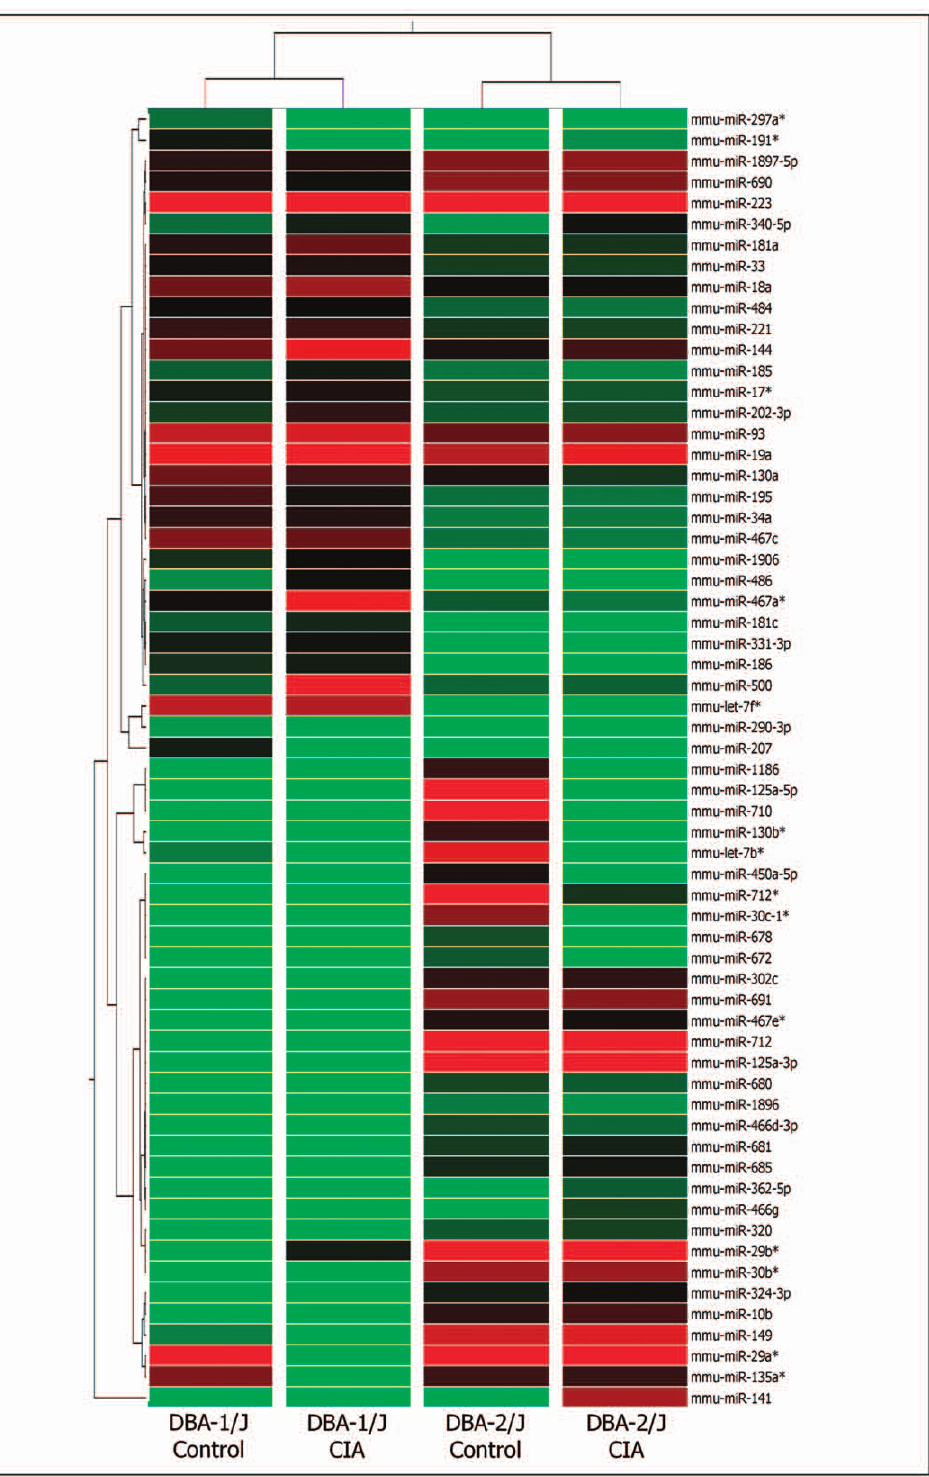
PLOS ONE | www.plosone.org 4 January 2013 | Volume 8 | Issue 1 |